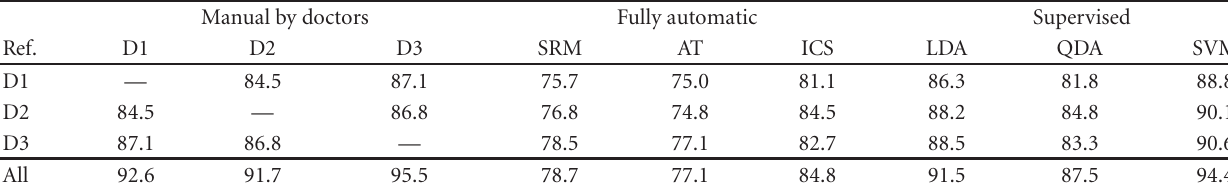
Table 3: Average accuracy of segmentation, quantified by the percentage of contour with an error ≤ 0.5mm, showing the performance of the proposed ICS method against alternative solutions. Borders manually drawn by three dermatologists, and their agreement, are considered as the ground-truth reference for accuracy